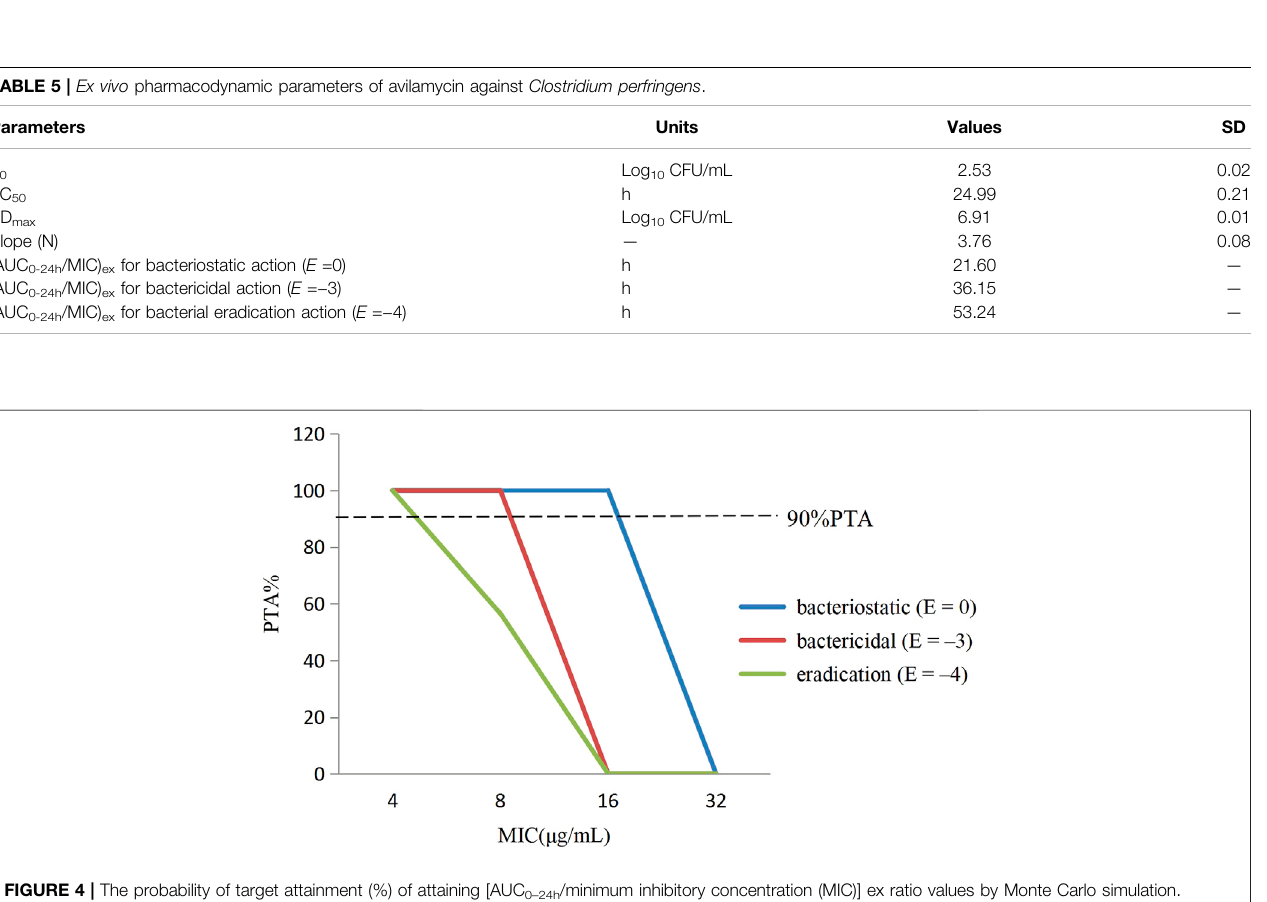
Frontiers in Pharmacology |